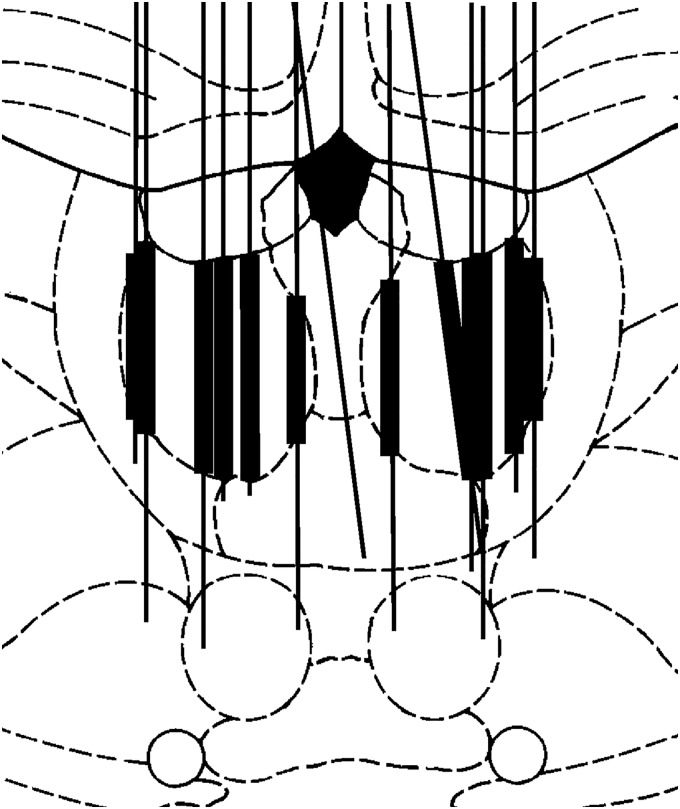
Anatomic locations of tetrode tracks, plotted on a section 6.2 mm anterior to the interaural line in Paxinos and Watson (1998). Narrow lines depict the course of the tracks penetrating through thalamus. Thick lines show the depths at which recorded neurons were assigned to MD and included in this report.